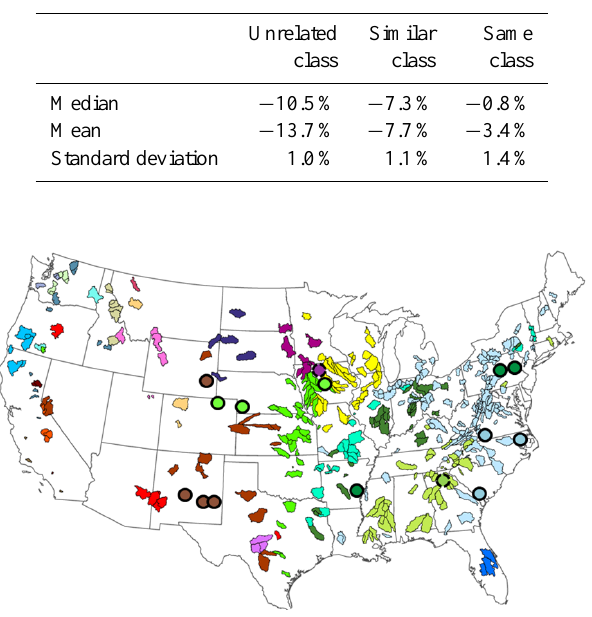
Figure 11. 428 MOPEX catchments colored by hydroclimatic class (Coopersmith et al., 2012). Fifteen SCAN sensors (for which the diagnostic soil moisture equation is calibrated) are shown as colored circles. Circle colors correspond to the hydroclimatic class of the point in question. Circles with dotted borders are unique (no other sensor for calibration is available within that